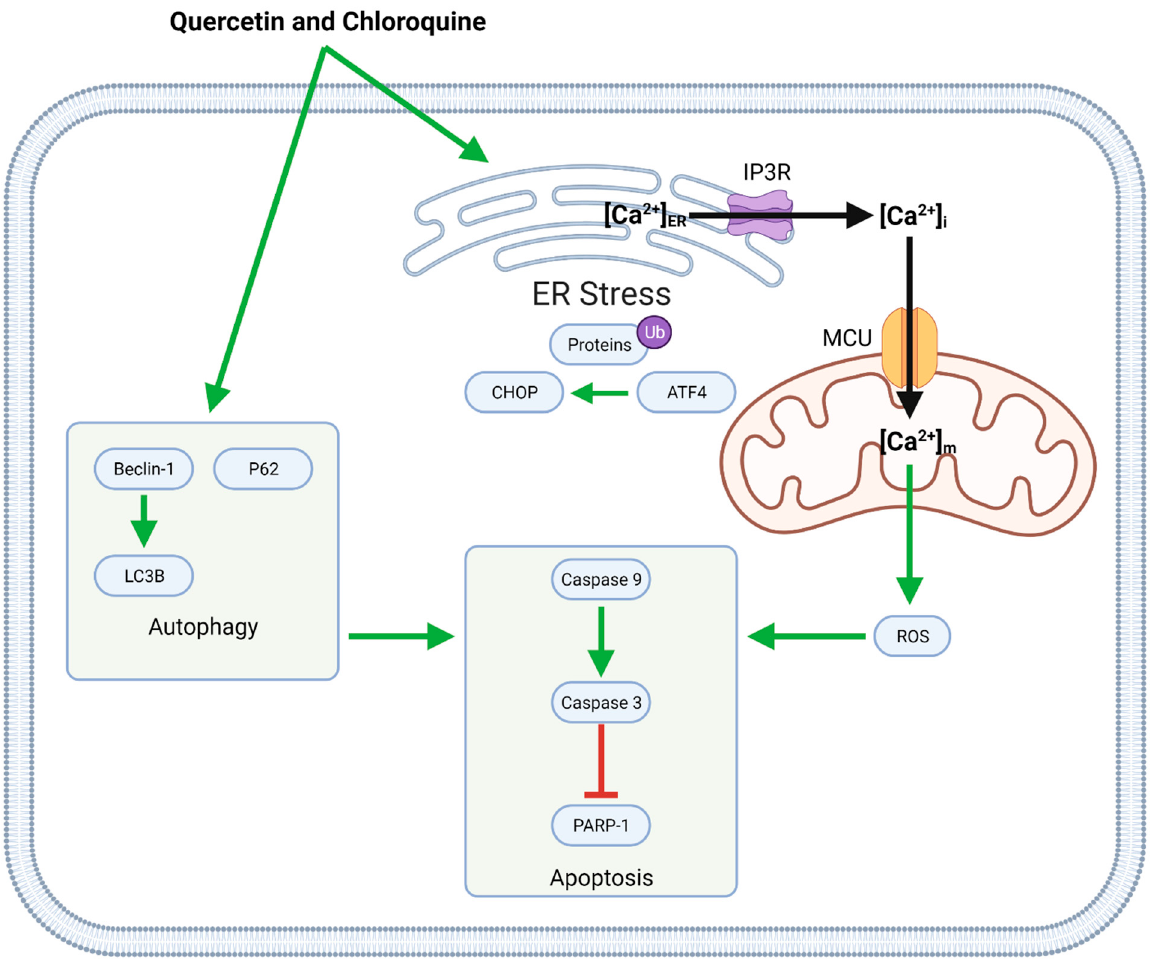
Figure 5. Synergistic anti-GBM effects of quercetin and chloroquine mediated by the induction of ER stress and autophagy. ER stress causes the release of Ca 2+ into the intracellular space; some of this Ca 2+ enters mitochondria via the MCU, leading to mitochondrial ROS generation. In this case, both mitochondrial ROS and autophagic mechanisms contribute to apoptotic cell death.